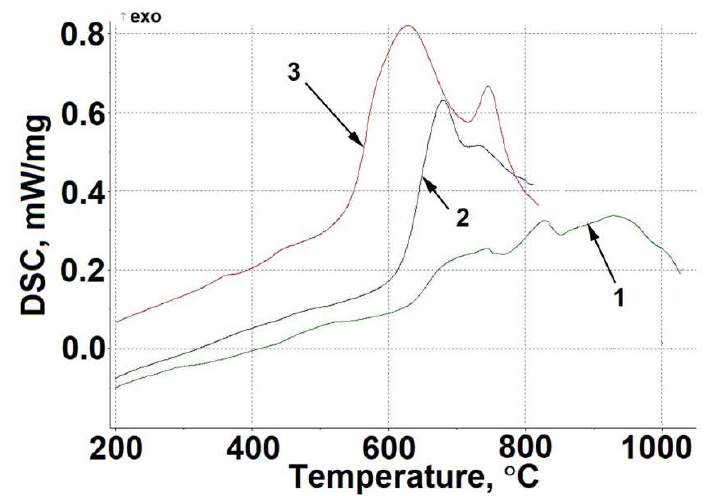
Figure 4. Results of the DSC study of “chromium + 15% nanodiamonds” composites: (1) after 0.5 h; (2) after 2 h; (3) after 4 h.